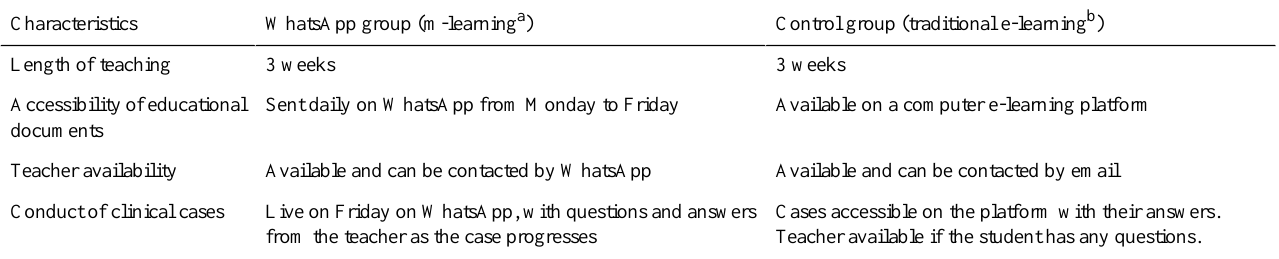
Table 1. Characteristics of WhatsApp-assisted m-learning and control e-learning used in this study. The two groups had the same program, learning objectives, and educational